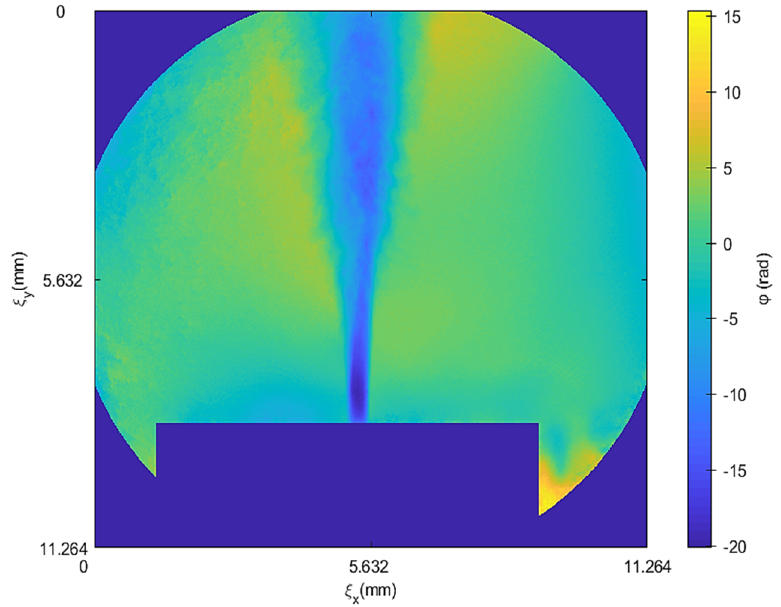
Figure 7. Averaged whole−field phase profile. Figure 8 shows the tomographic reconstruction from the averaged phase values (see Figure 6a for